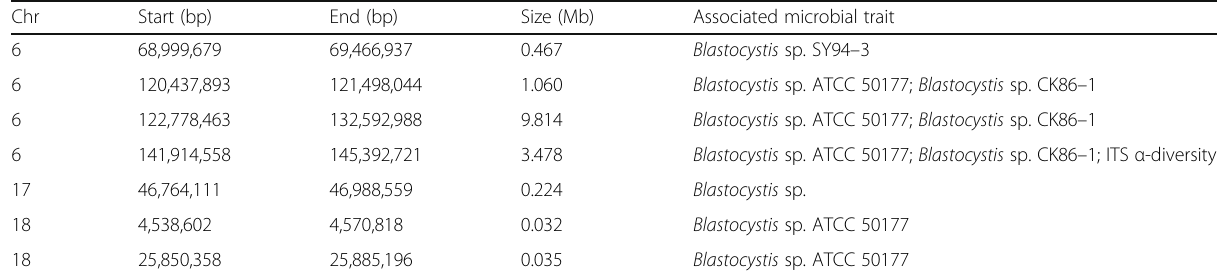
Table 3 Resume of the chromosomal intervals identified by the GWAS Chr Start (bp) End (bp) Size (Mb) Associated microbial